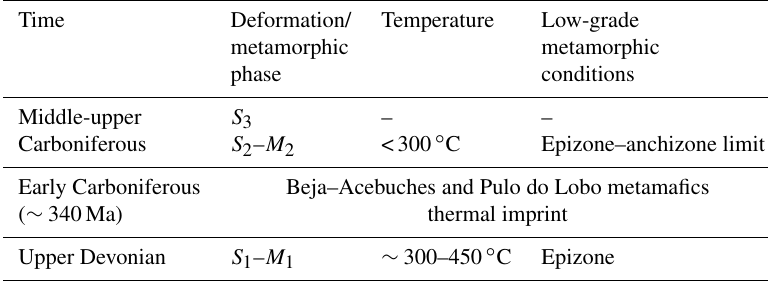
Table 2. Summary of the tectonometamorphic Variscan evolution of the Pulo do Lobo